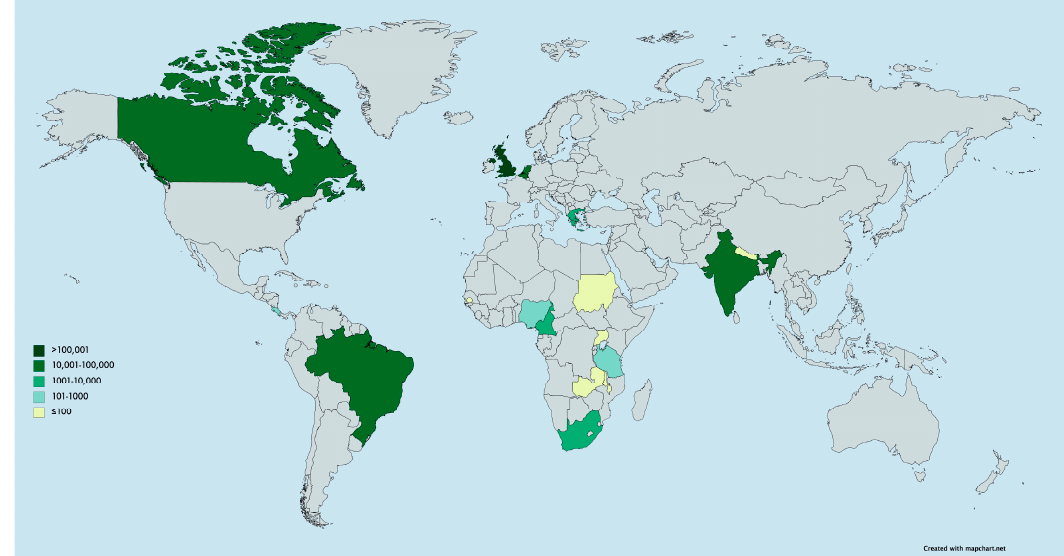
Figure 1. Map of the worldwide distribution of survey respondents and total number of COVID-19 cases at the time of survey completion (created with mapchart.net).